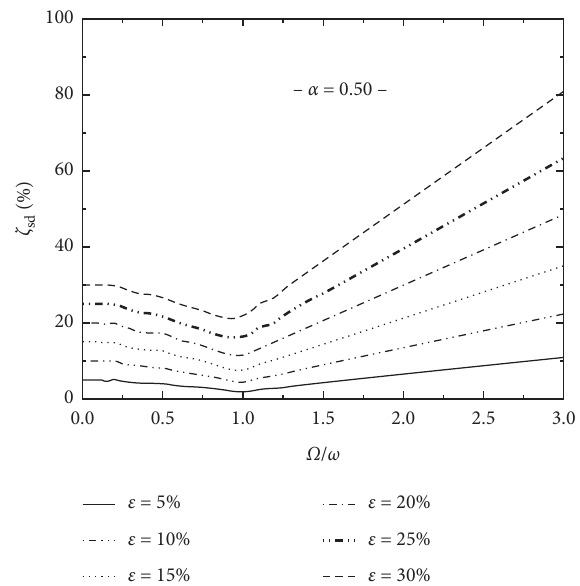
Figure 1: Relationship between the ADR and the frequency ratio for different damping indices ( ε ) under harmonic